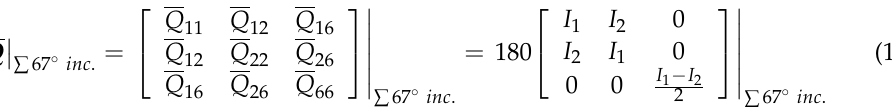
Figure 3. Schematic of 67° rotation increments of a layer using a raster scanning strategy.